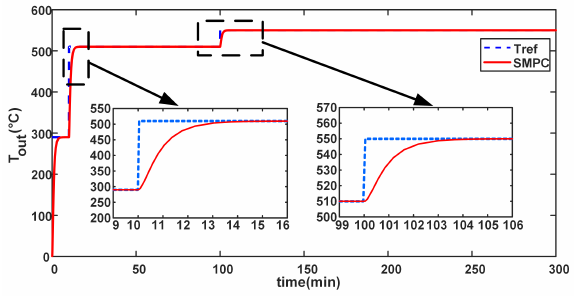
Fig. 6. Collector field outlet temperature under SMC.